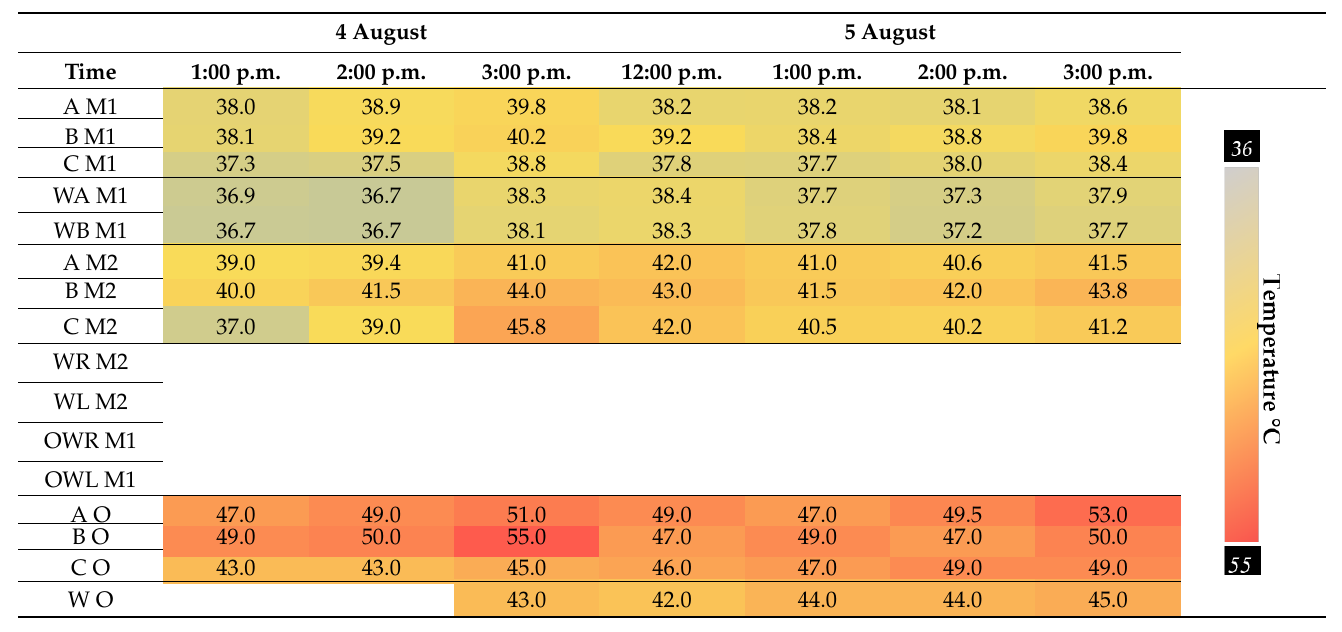
Table 10. Surface temperature measurements of Room 1, Room 2, and the courtyard on 4 and 5 August 2018.